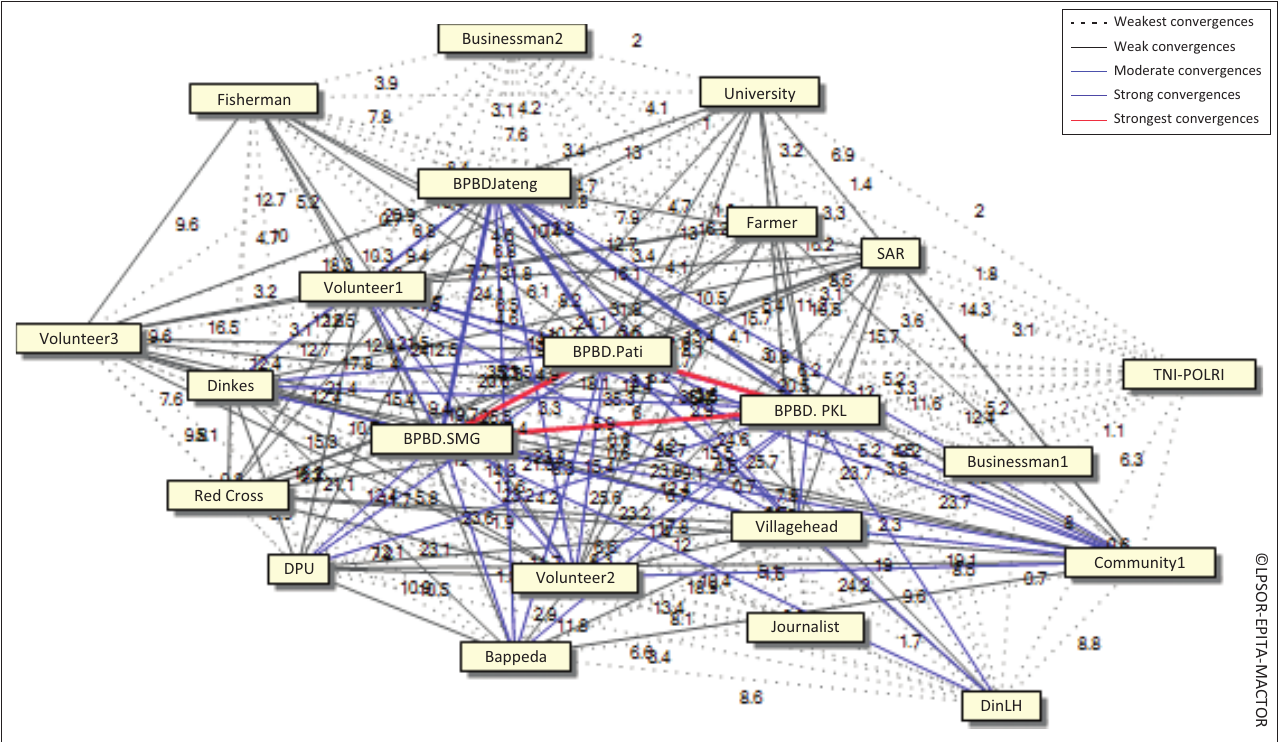
FIGURE 7: Actor relationships in reducing flood